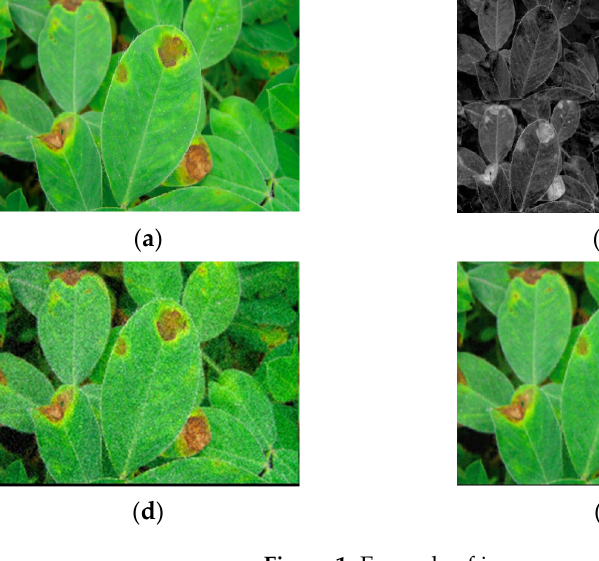
Figure 1. Example of image preprocessing operations (channel separation ( b ), mean shift filtering ( c ), noise detection ( d ), filter detection ( e ), and inversion ( f ) operations are performed on the original picture ( a ), respectively).